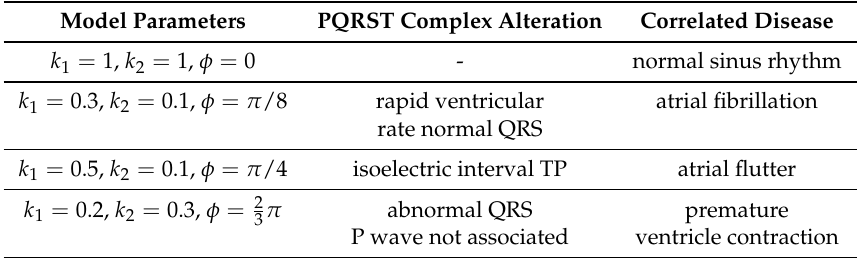
Table 3. Some synthetic diseases by the modified heart dipole model (MHDM). Model Parameters PQRST Complex